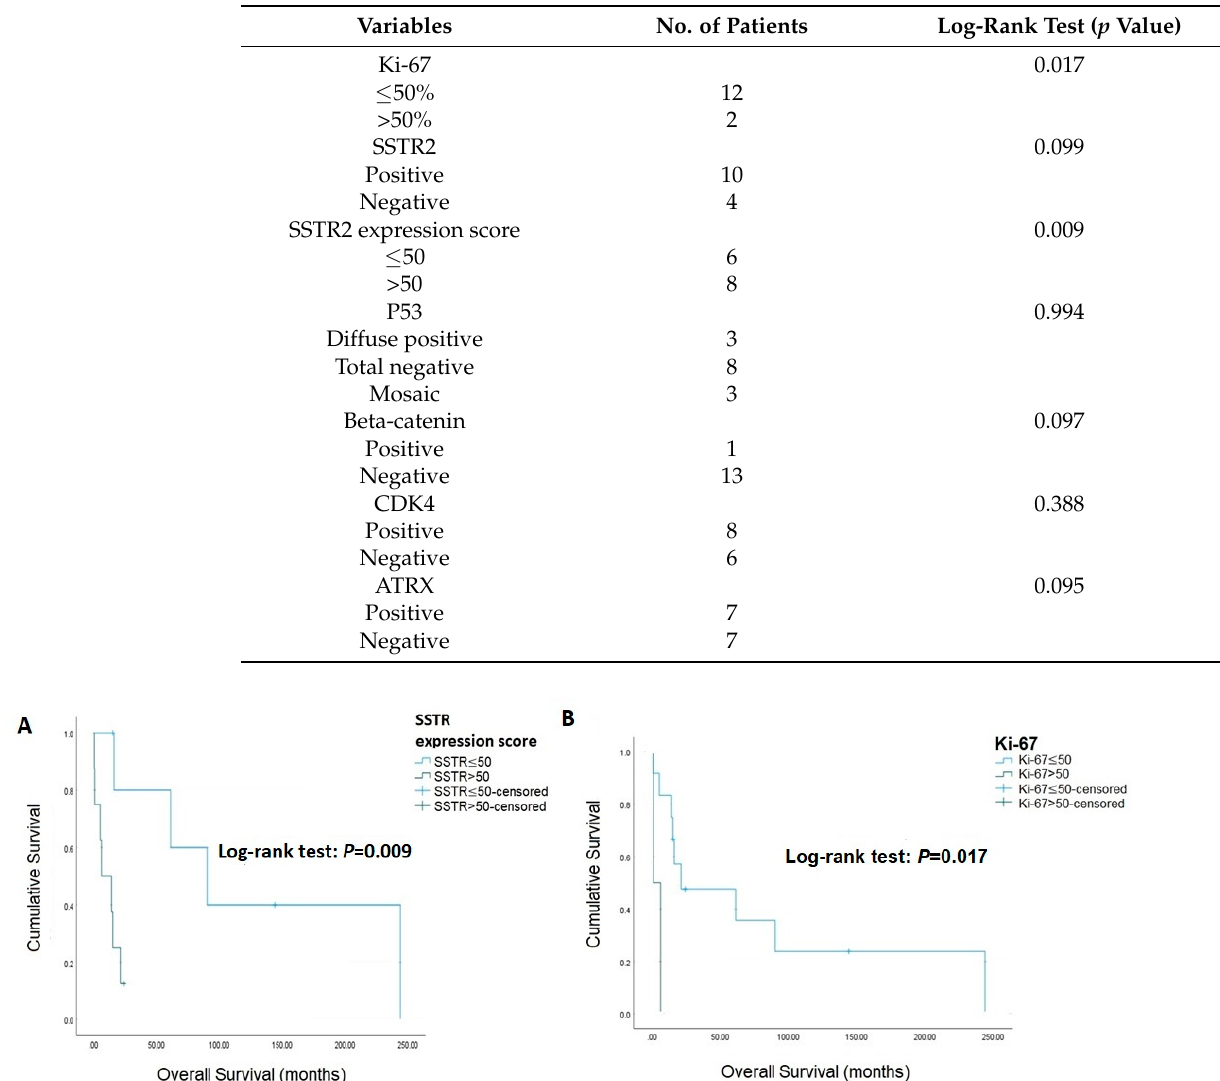
Table 3. The association of immunohistochemical staining with survival in ACC.